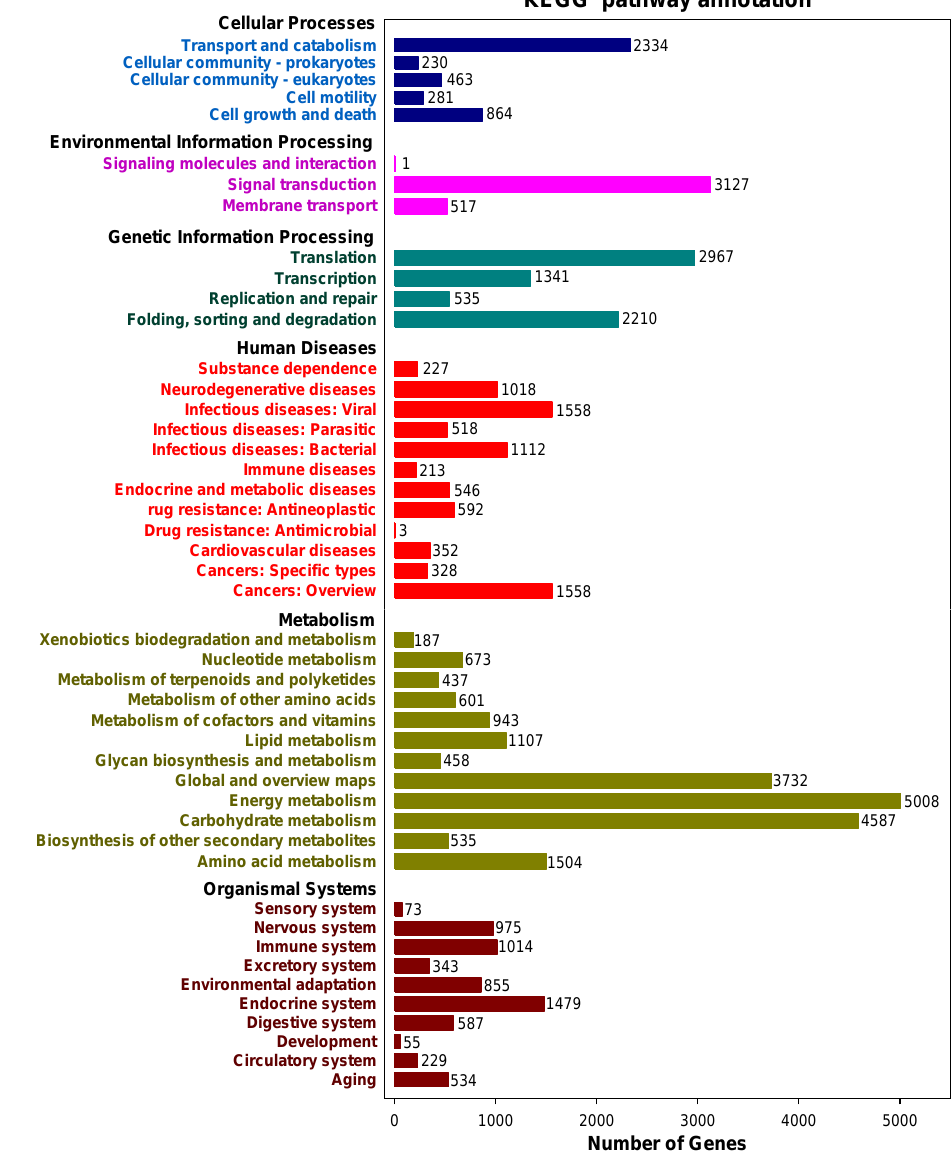
Figure 4. Kyoto Encyclopedia of Genes and Genomes (KEGG) annotated pathways and numbers of the gene in purslane ( Portulaca oleracea